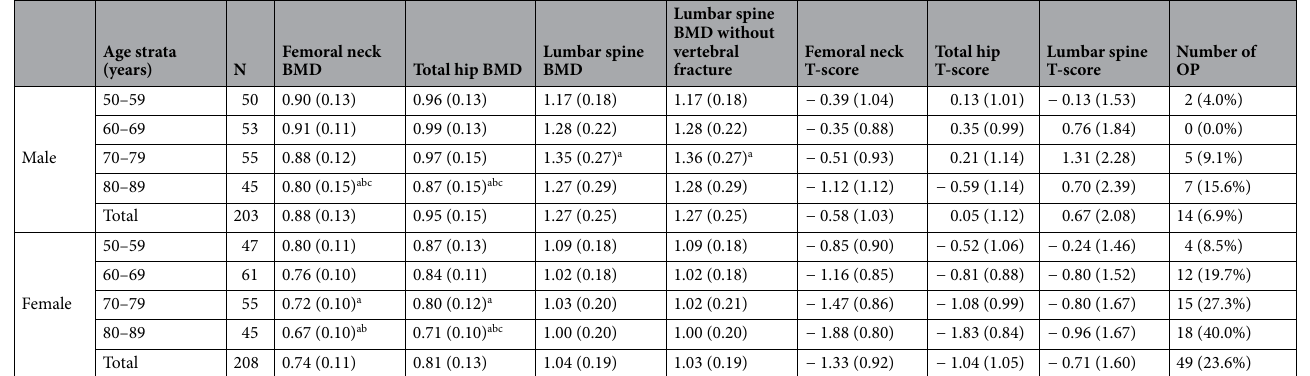
Table 3. Bone mineral density and T-score at the femoral neck, proximal femur, and lumbar 1–4, in addition to prevalence of osteoporosis. Values represent mean (standard deviation). Values of OP represent number (prevalence). One female patient aged 70s and 3 female patients aged 80s were excluded due to the artificial head replacement surgeries. BMD: bone mineral density, OP: osteoporosis. a Significantly different (p < 0.05) values from those aged 50–59 years. b Significantly different (p < 0.05) values from those aged 60–69 years. c Significantly different (p < 0.05) values from those aged 70–79 years.